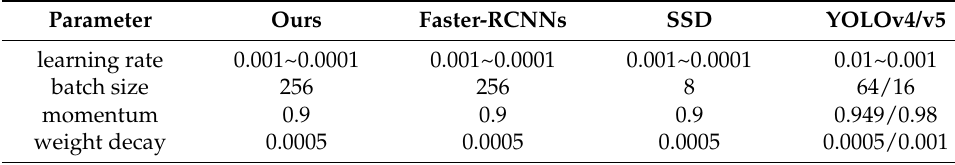
Table 2. Common parameters of the schemes [16,27,33,34].